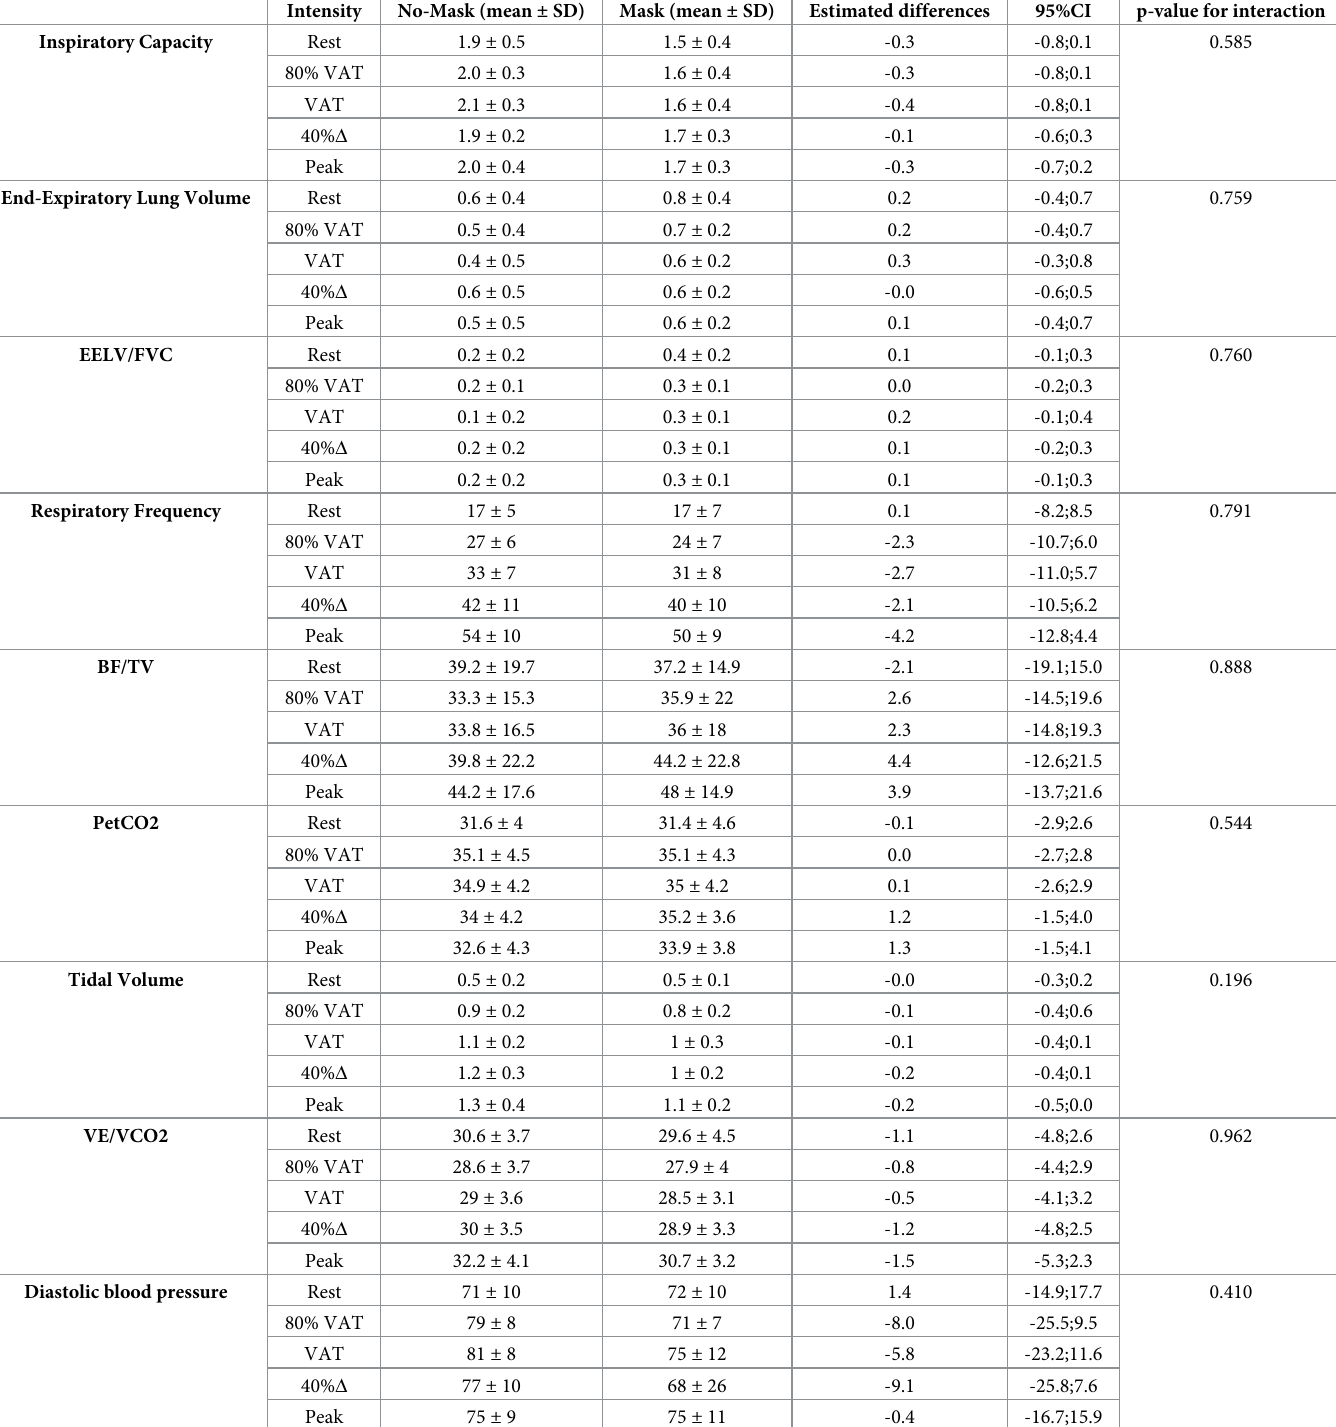
Table 2. Data from progressive square-wave test with or without wearing a